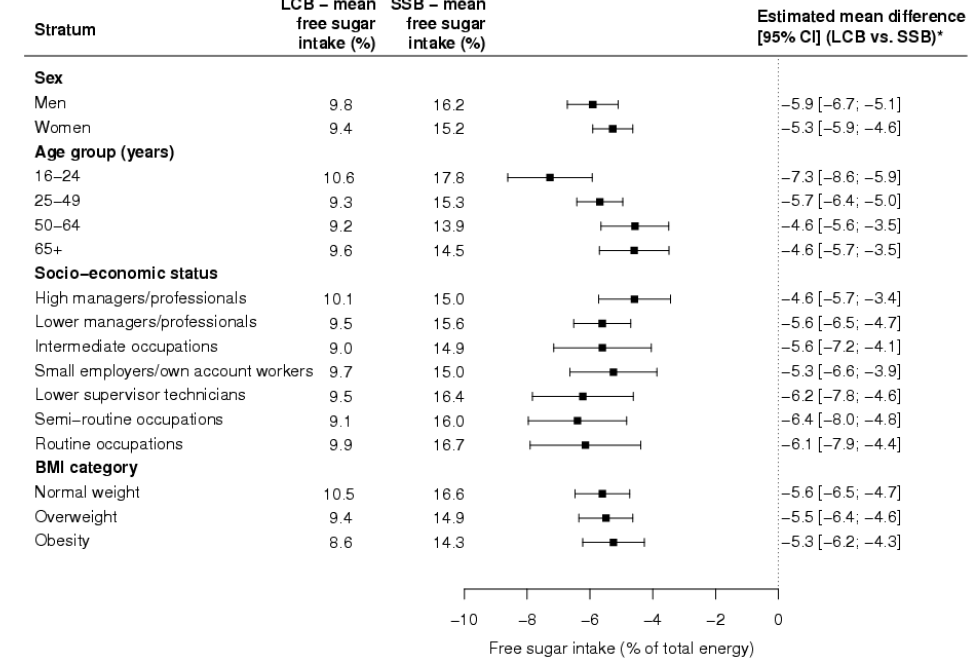
Figure 1. Differences in free sugar intake between the low-calorie (LCB) and sugar-sweetened beverage (SSB) group and corresponding 95% confidence intervals (CIs) according to strata of sex, age, socioeconomic status and body mass index (BMI). * The estimates were obtained by multiple linear regression models adjusted for age, socioeconomic status and BMI (for sex strata); adjusted for sex, socioeconomic status and BMI (for age strata); adjusted for sex, age, and BMI (for socioeconomic status strata); adjusted for sex, age, and socioeconomic status (for BMI